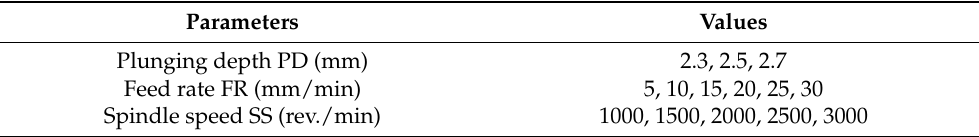
Table 3. FSSW parameters for experimental study.